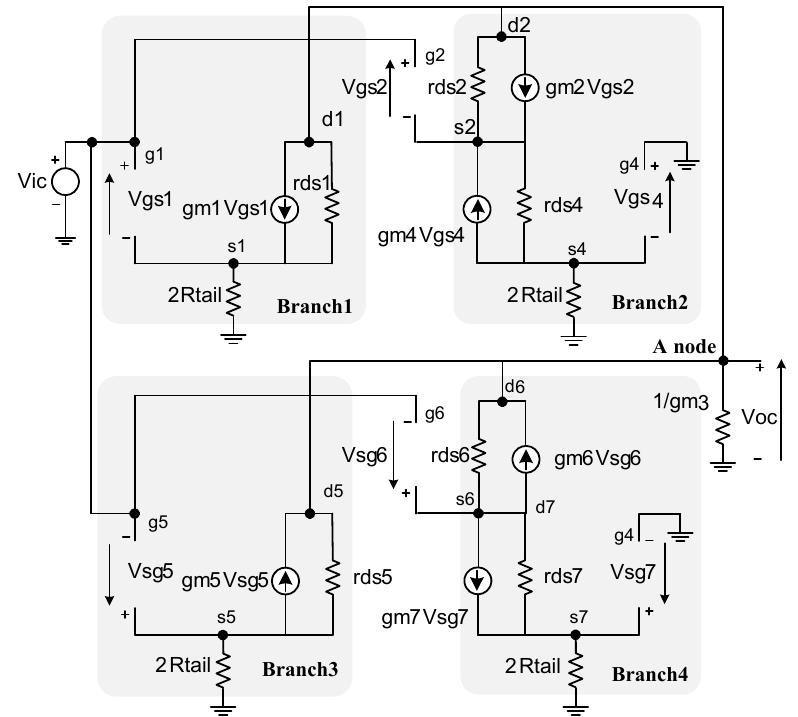
Figure 5. Small-signal equivalent half circuit of the LGA.